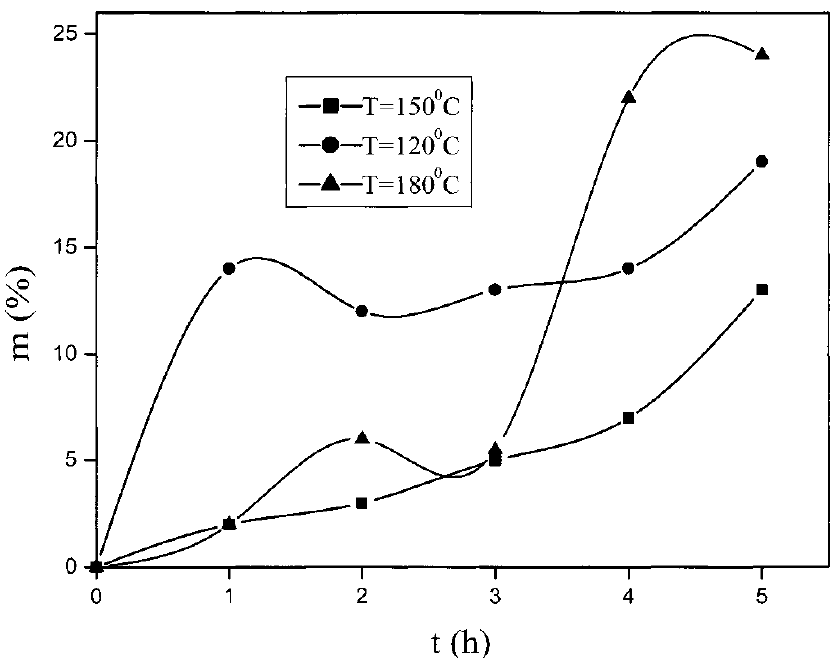
FIGURE 2 Dependence of m on t under the normal